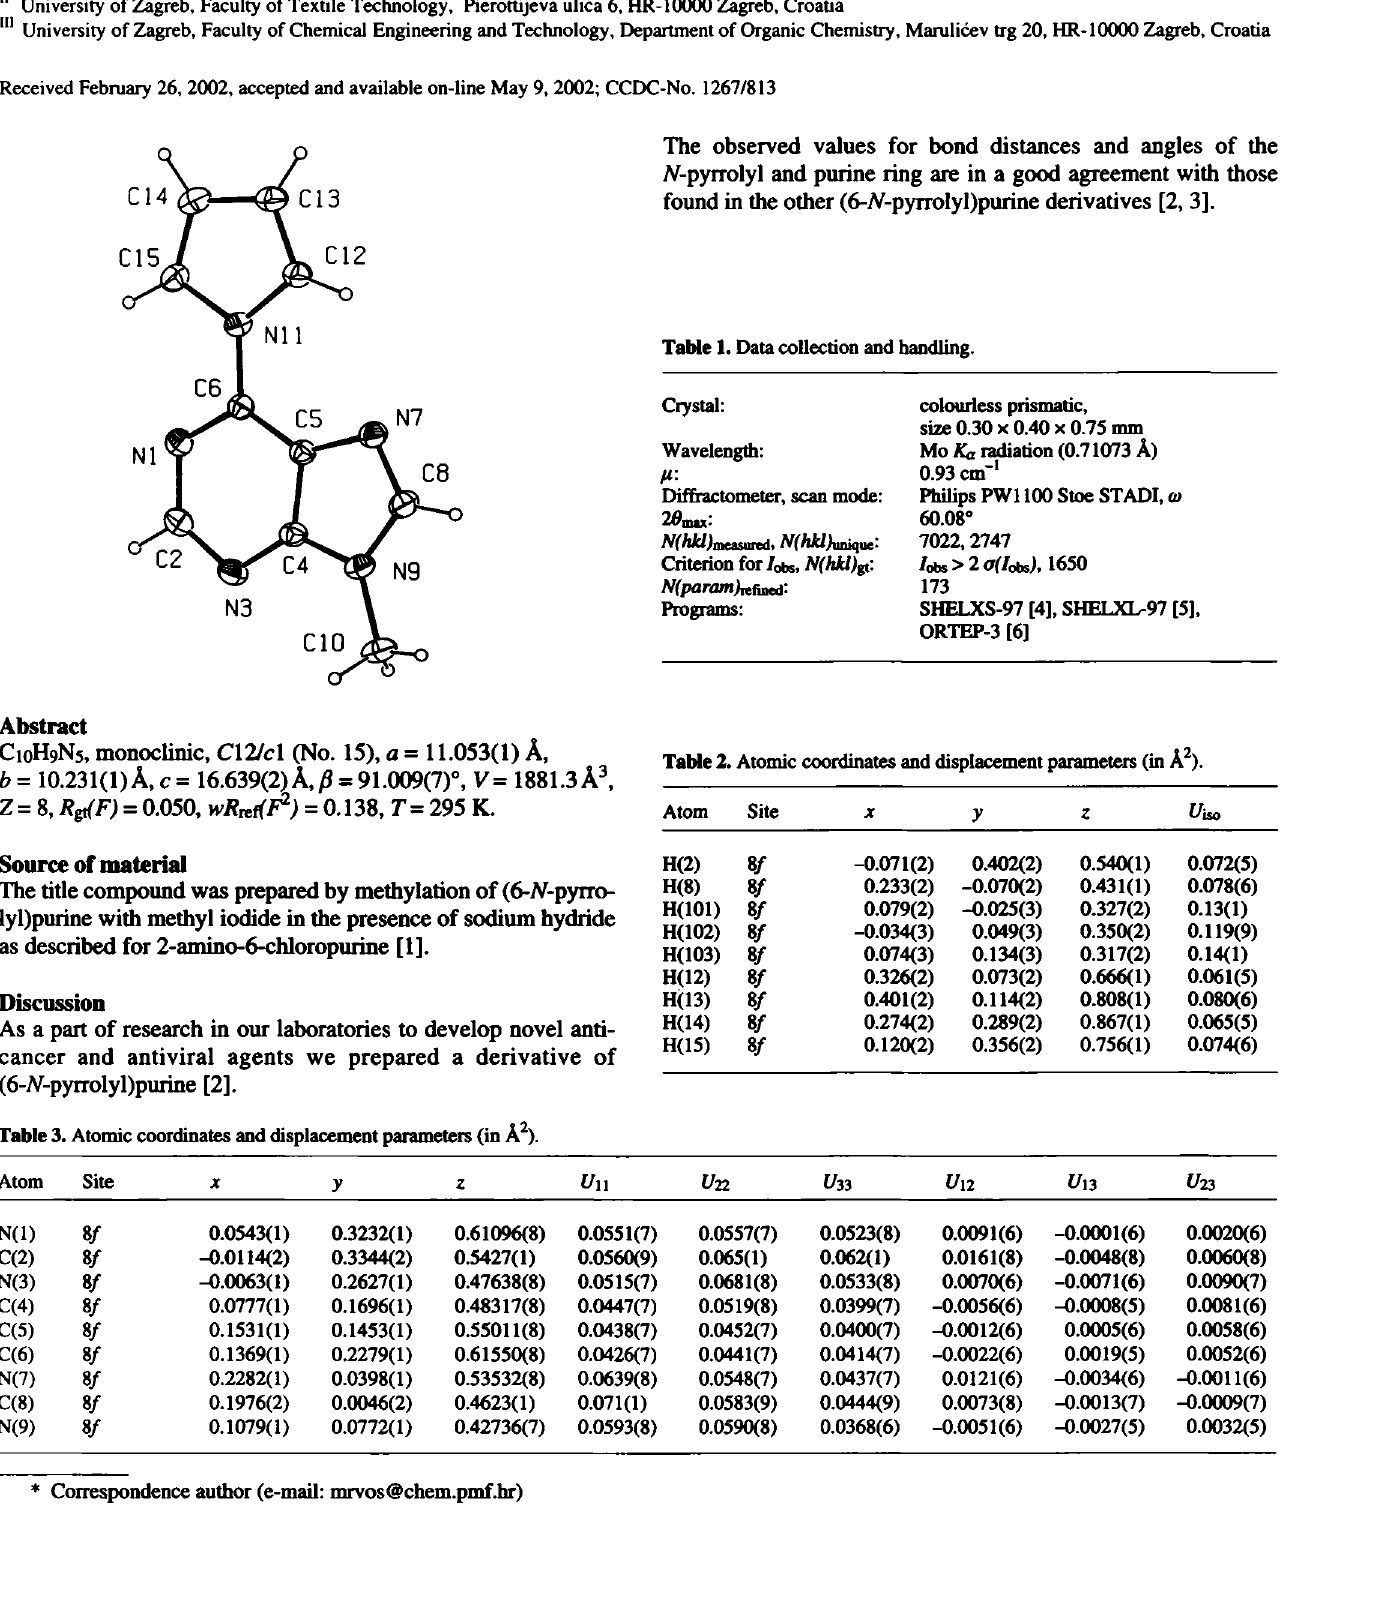
Table 3. Atomic coordinates and displacement parameters (in Â 2 ).